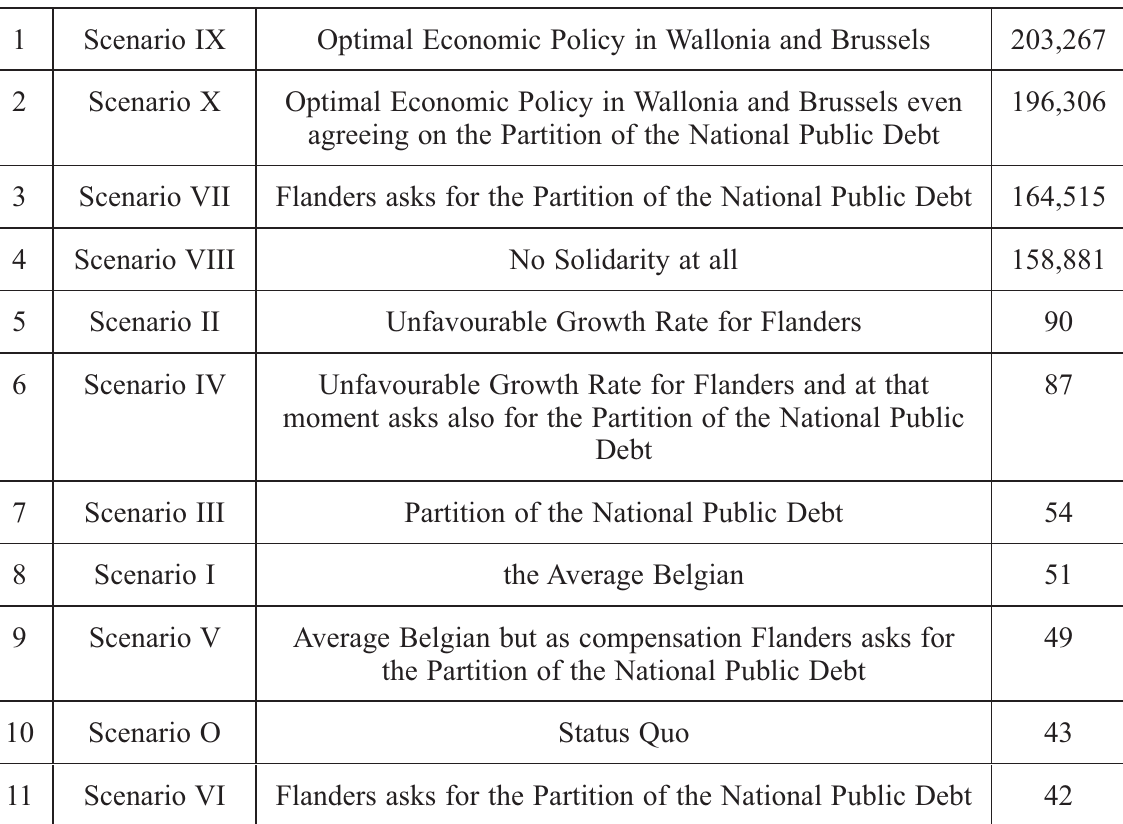
Table 4. Ranking of the Scenarios by the Full-Multiplicative Method at the Year